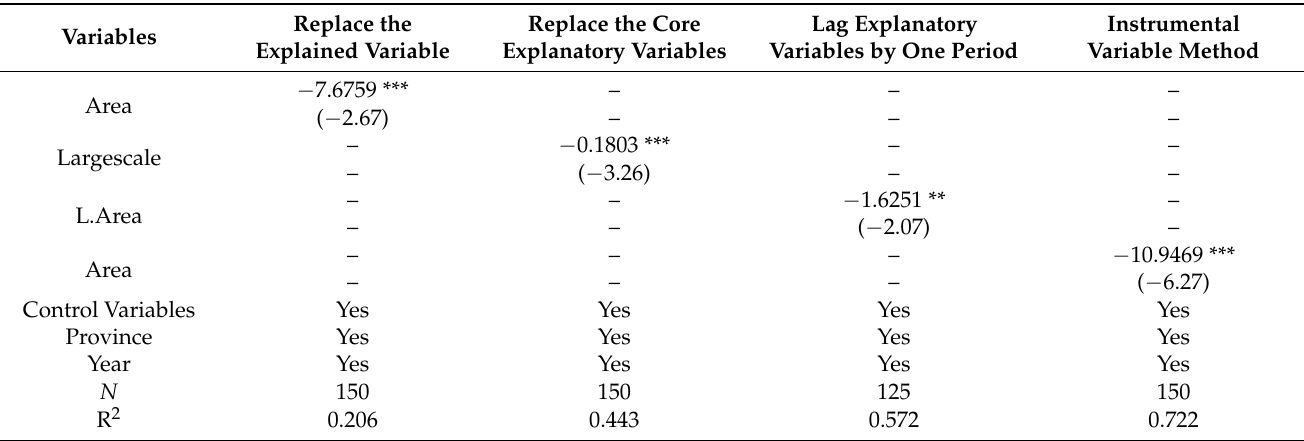
Table 5. Results of robustness